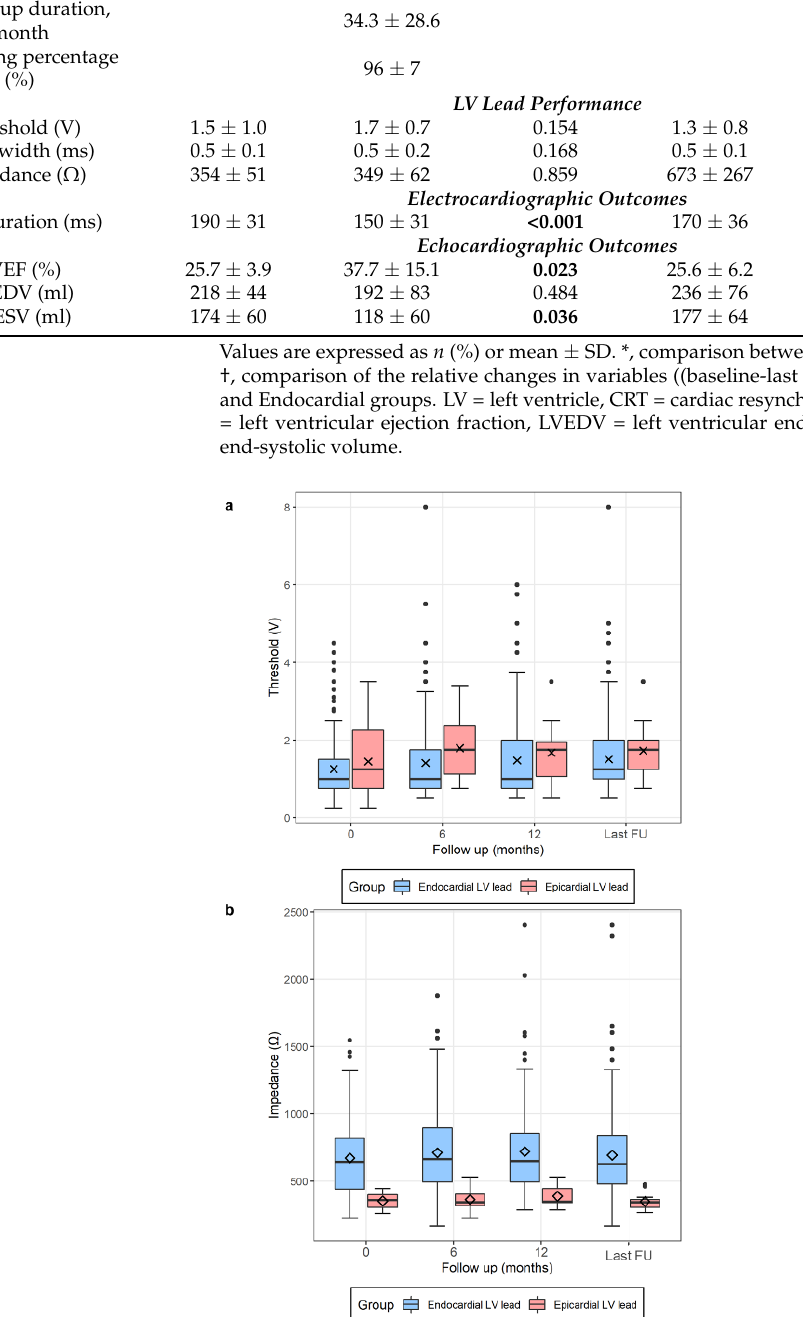
Table 3. A comparison of the two groups at baseline and during the follow-up. Epicardial LV Lead ( n = 13) Last p Value * Baseline Baseline Follow-Up Follow-Up